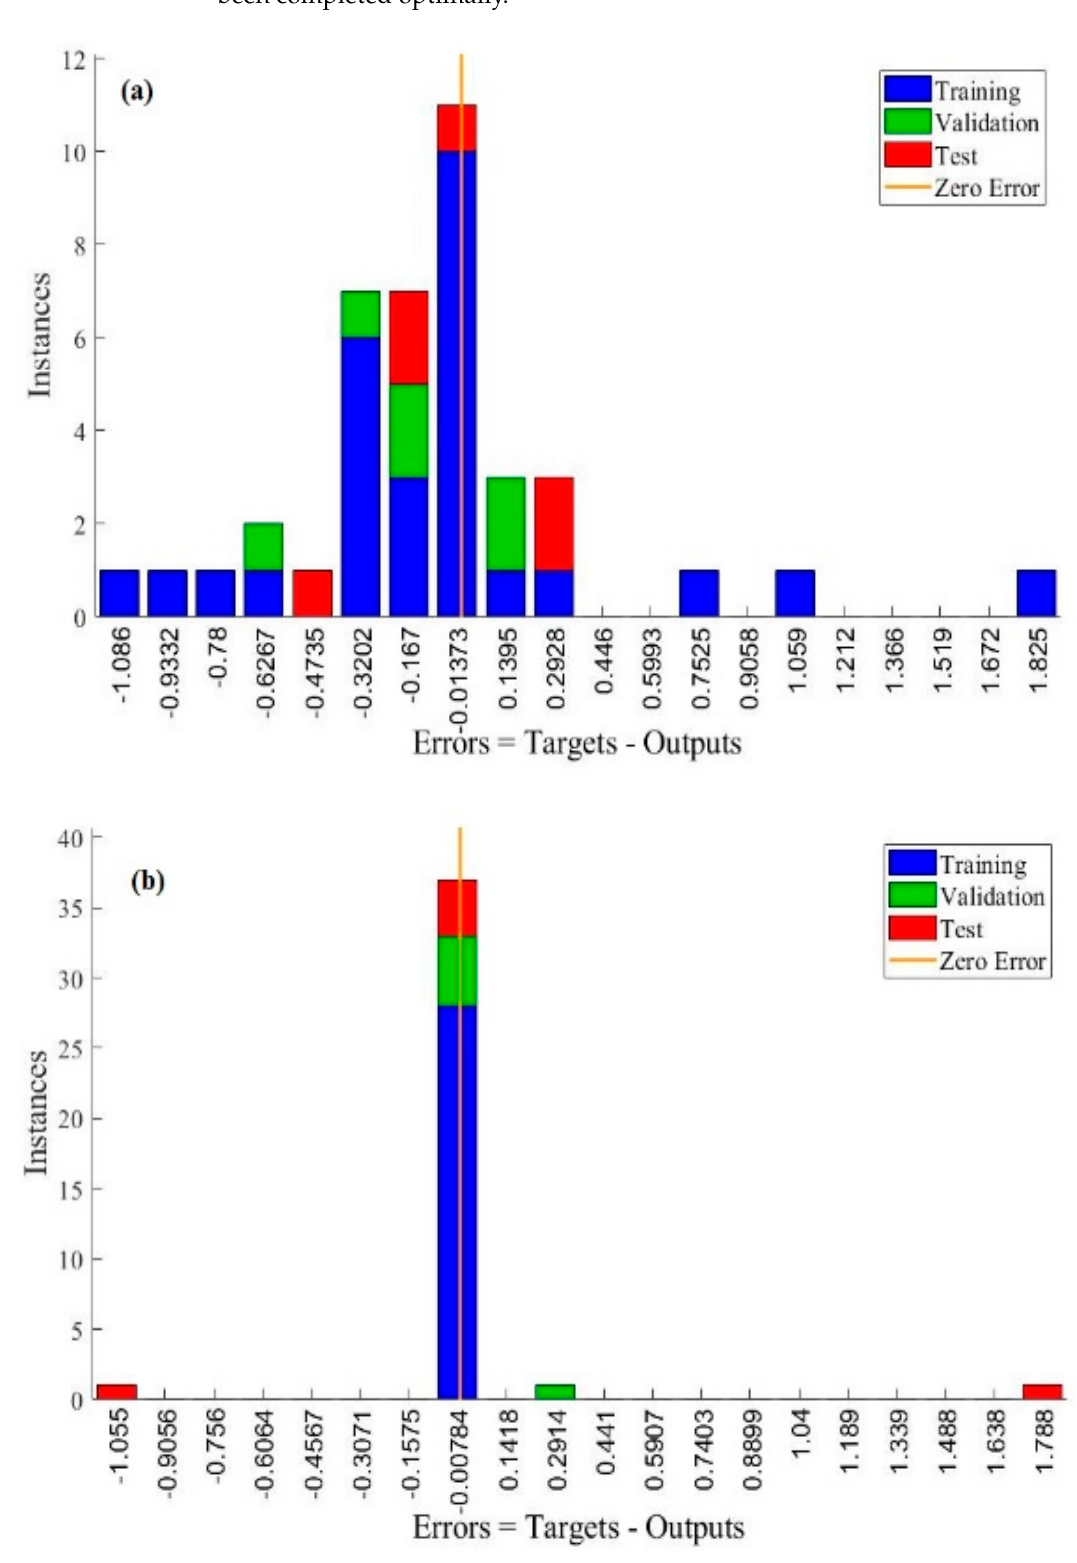
Figure 4. ( a , b ). The training performance graph of the ANN model for M = 0 and M = 0.2.